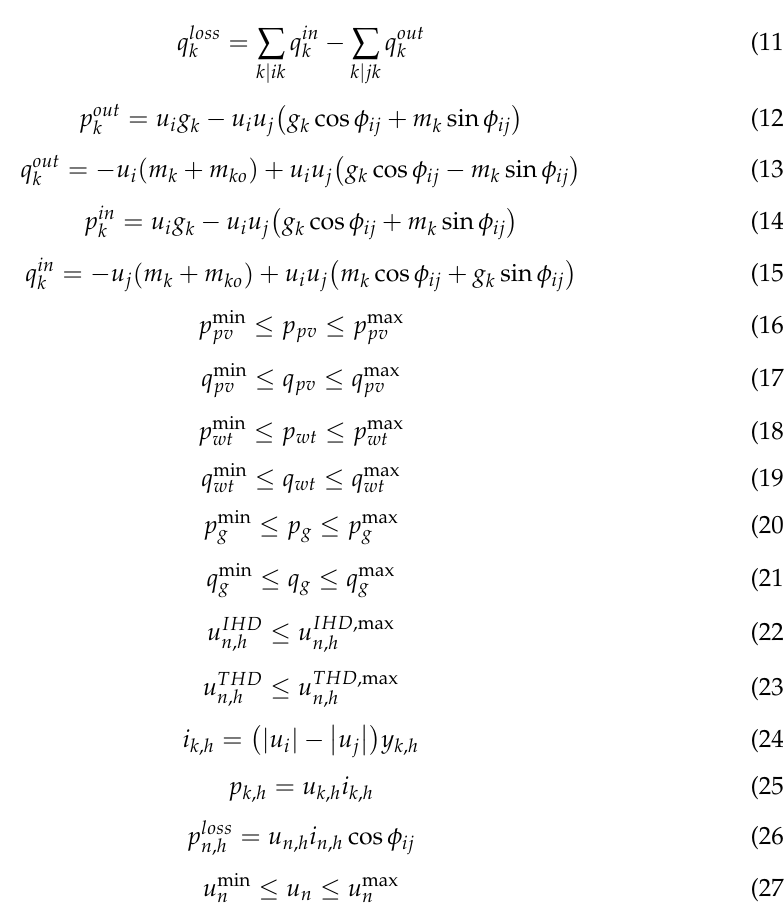
and p max represent the minimum and maximum active g